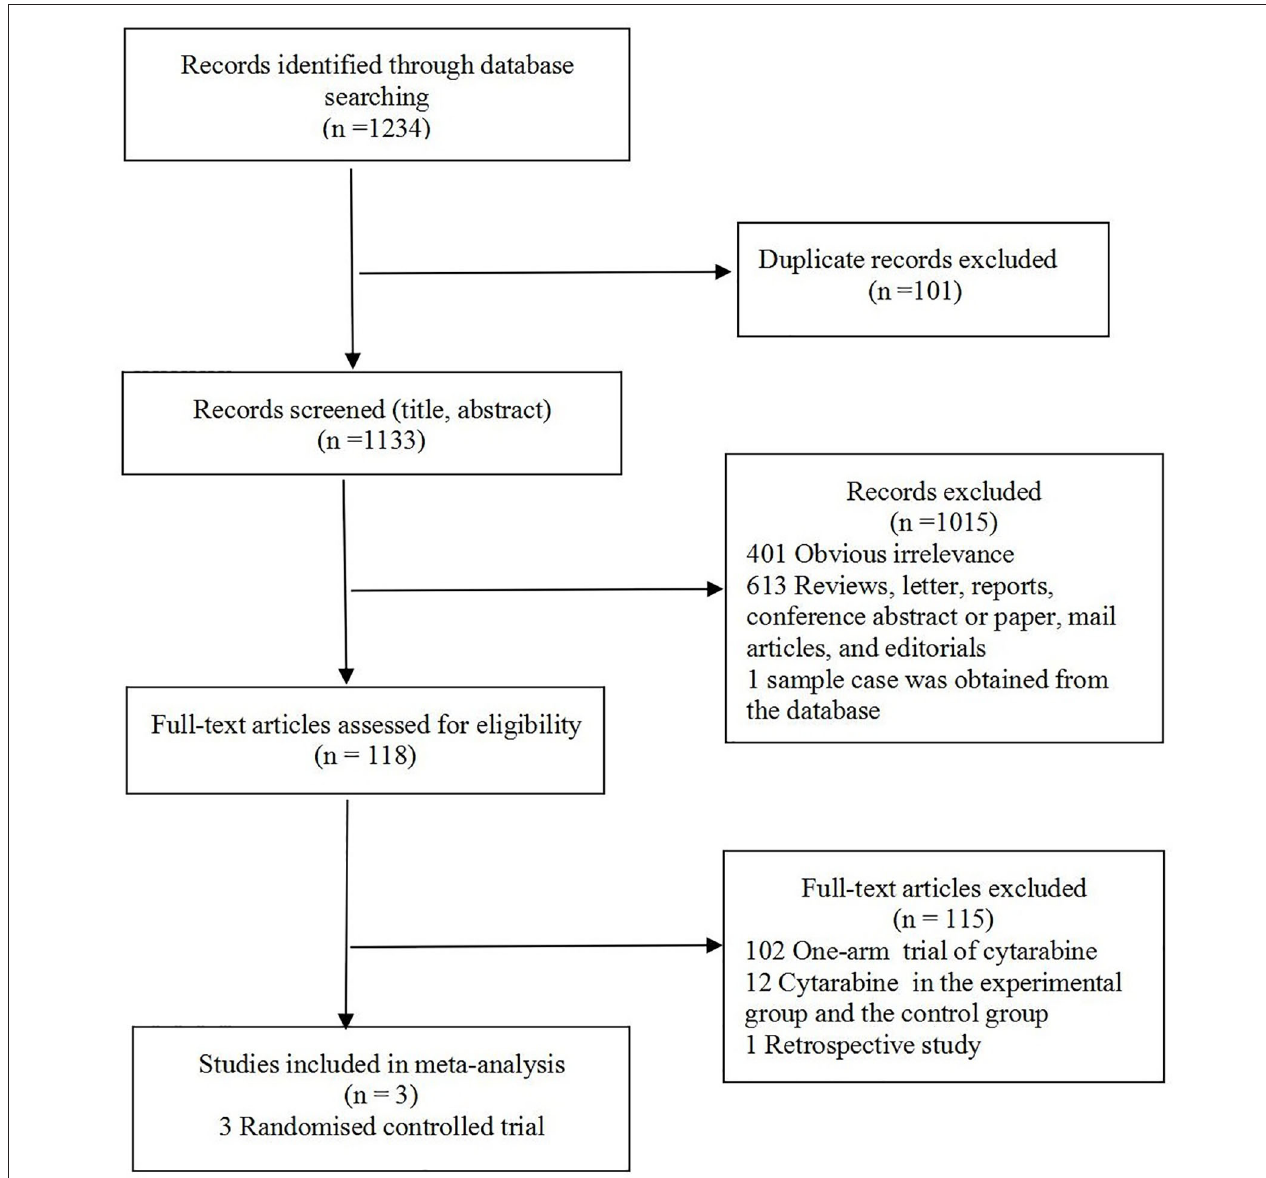
FIGURE 1 | Flow diagram of the study selection